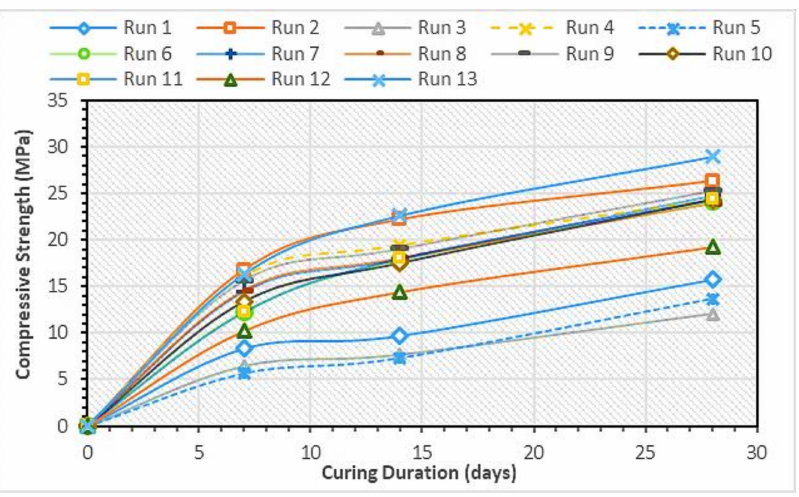
Figure 6. Rate of compressive strength development for the HVFA–CRC.